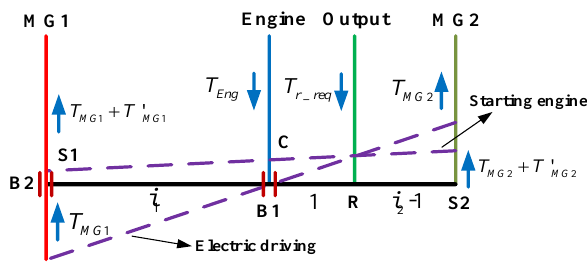
Figure 6. Lever chart during engine starting process.